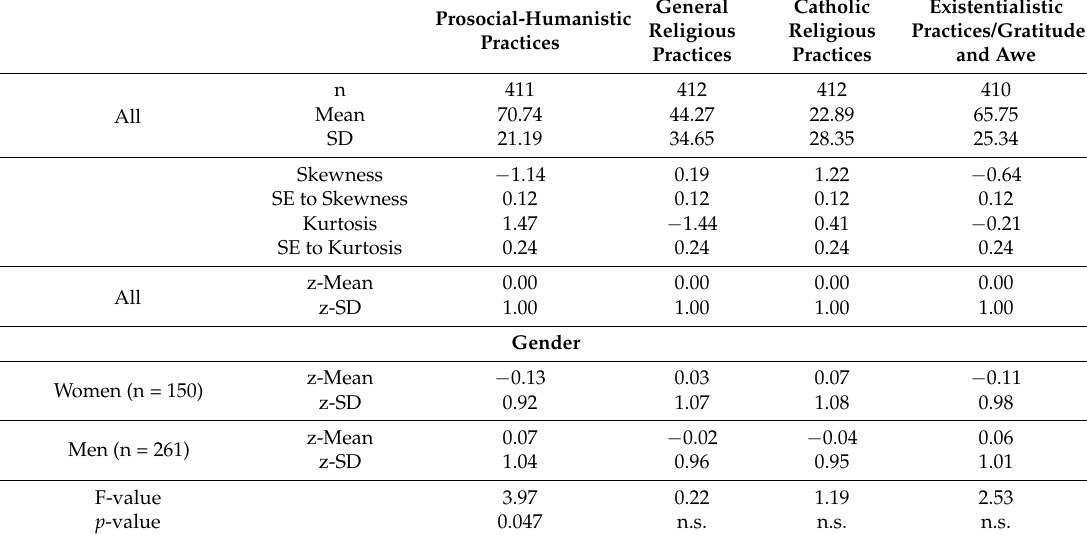
Table 5. Mean values in the